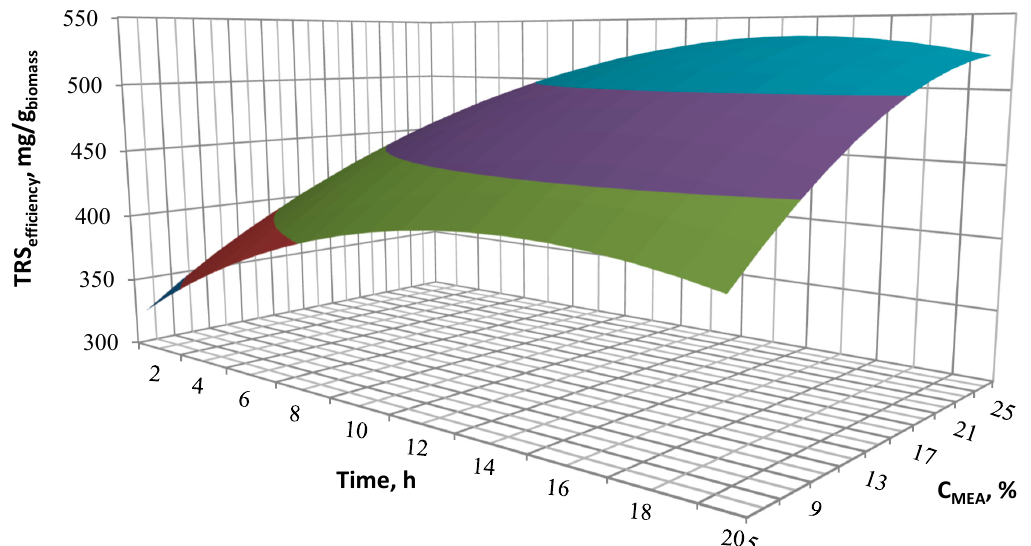
Figure 6. Influence of the pre-treatment time and MEA concentration on the TRS efficiency.